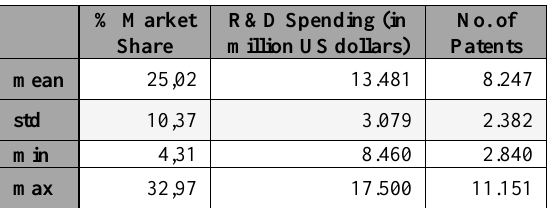
Table 9: Blackberry Ten Years Data (2010-2019)